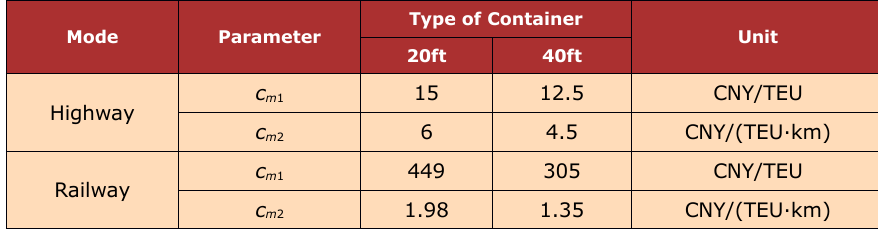
Table 2. Values of the transportation cost parameters